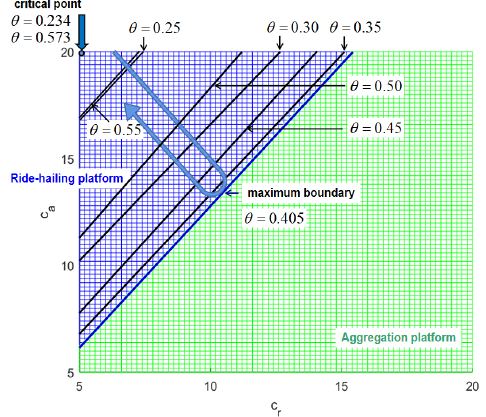
Figure 17. The boundaries and critical points on c r − c a plane in Model